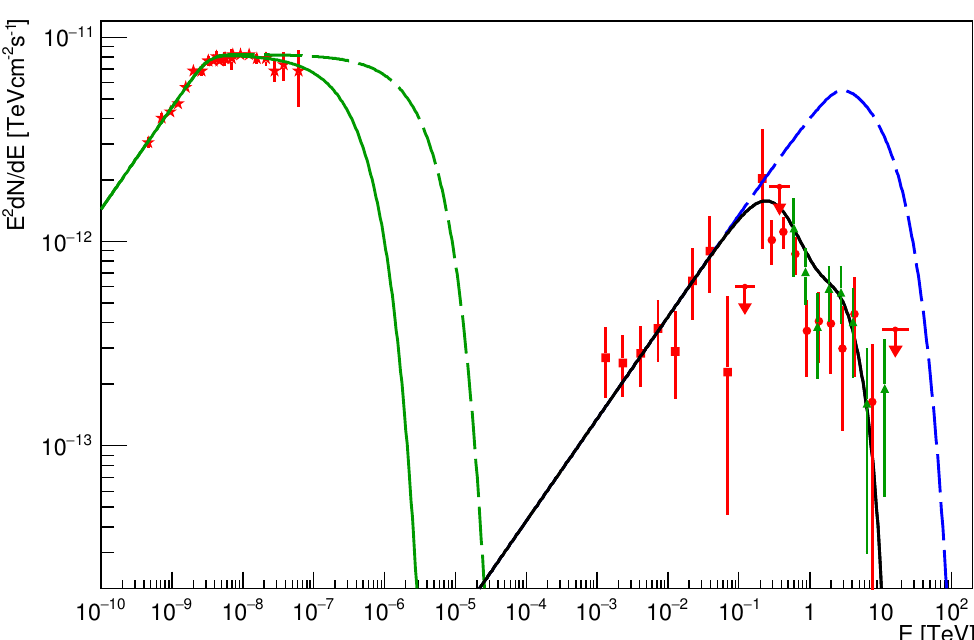
Figure 3. The high-energy part of the SED for 1ES 0229+200. Red symbols denote the measured SED: stars—X-ray measurements, squares—the Fermi-LAT SED, circles—VERITAS measurements, triangles—H.E.S.S. measurements. Arrows denote Fermi-LAT and VERITAS upper limits. Green curves denote fits to the X-ray component assuming different values of the maximum energy of the primary electrons: 100 TeV for solid curve and 300 TeV for dashed curve, dashed blue curve— the intrinsic γ -ray component but including the redshift effect, black curve—the observable γ -ray component including redshift and the EBL